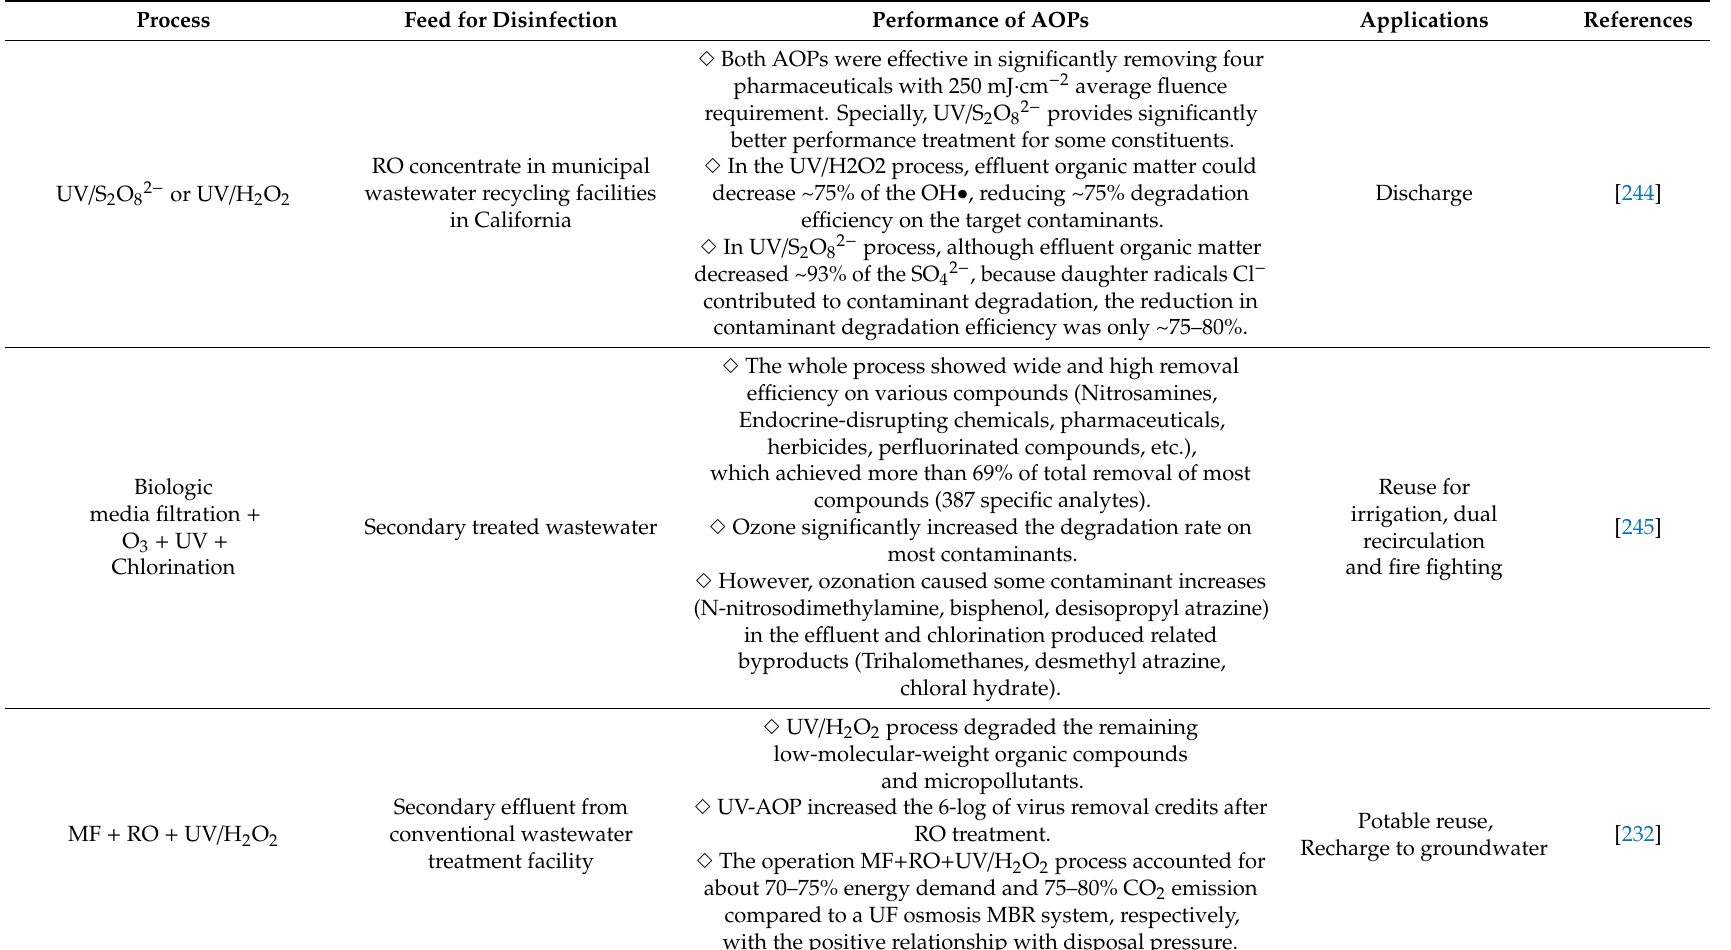
Table 12. Combination of membrane processes with advanced oxidation processes (AOPs) for wastewater reuse